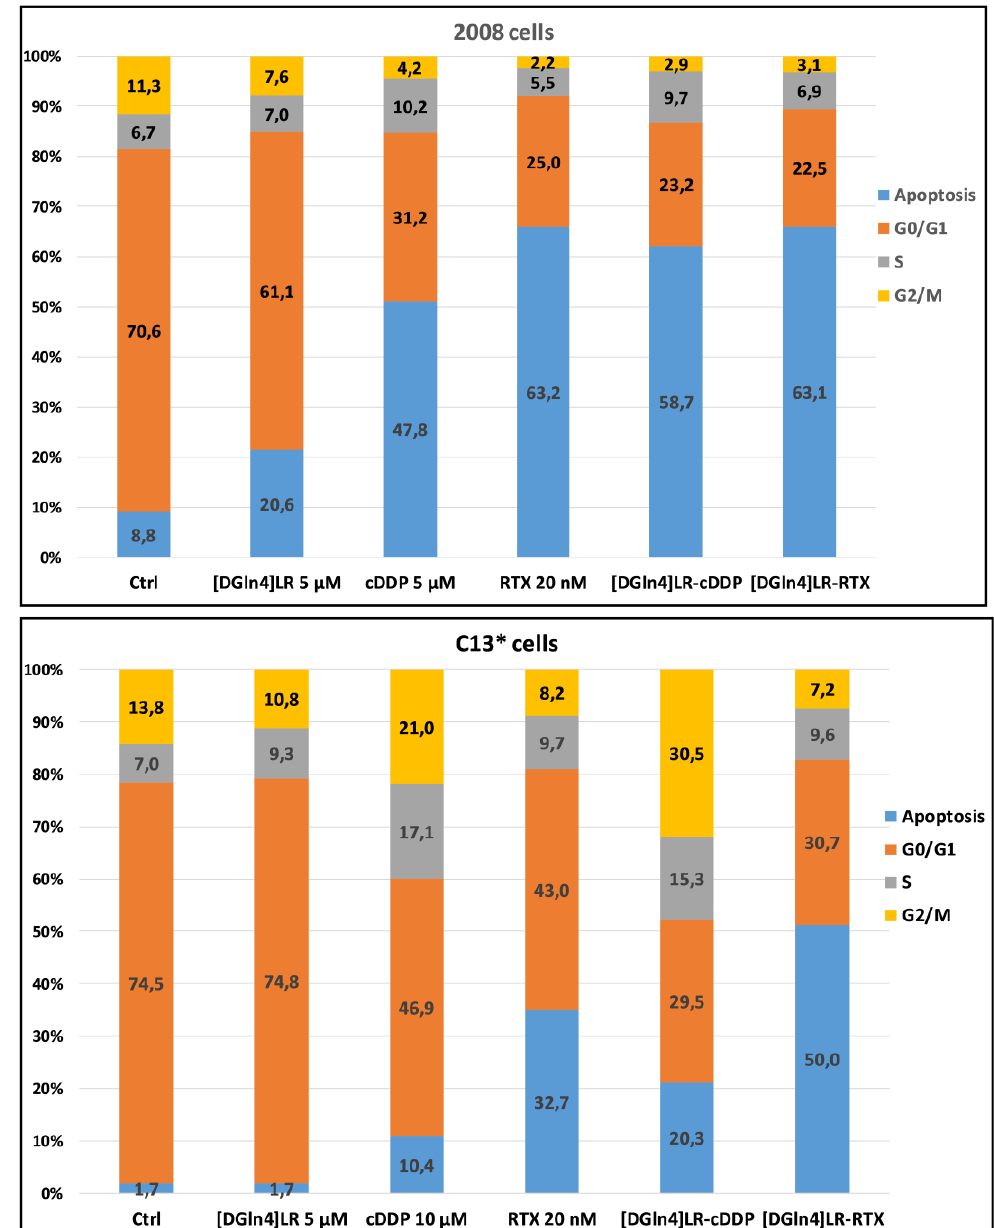
Figure 6. E ff ect of the [DGln4]LR peptide and cDDP alone and in combination on the cell cycle phase distribution of 2008 and C13* cells by cytofluorimetric analysis of the DNA content by PI staining. After a 72 exposure to 5 µ M [DGln4]LR and 5 µ M (2008 cells) or 10 µ M (C13* cells) cDDP or 20 nM RTX alone and in concurrent combinations, cells were processed according to Section 4. The inserted numbers indicate the percentages of cells in the di ff erent phases of the cell cycle and are the mean of two / three experiments. The error bars were omitted for a clearer